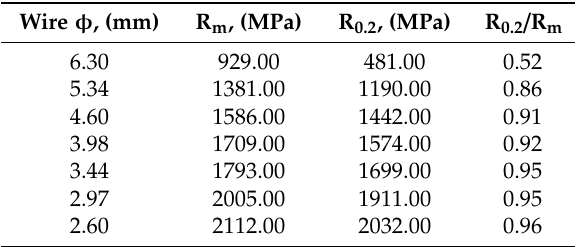
Table 5. Results of tests regarding the mechanical properties of TRIP steel wires drawn as per variant B (V c = 1.6 m / s, high single drawing reductions).